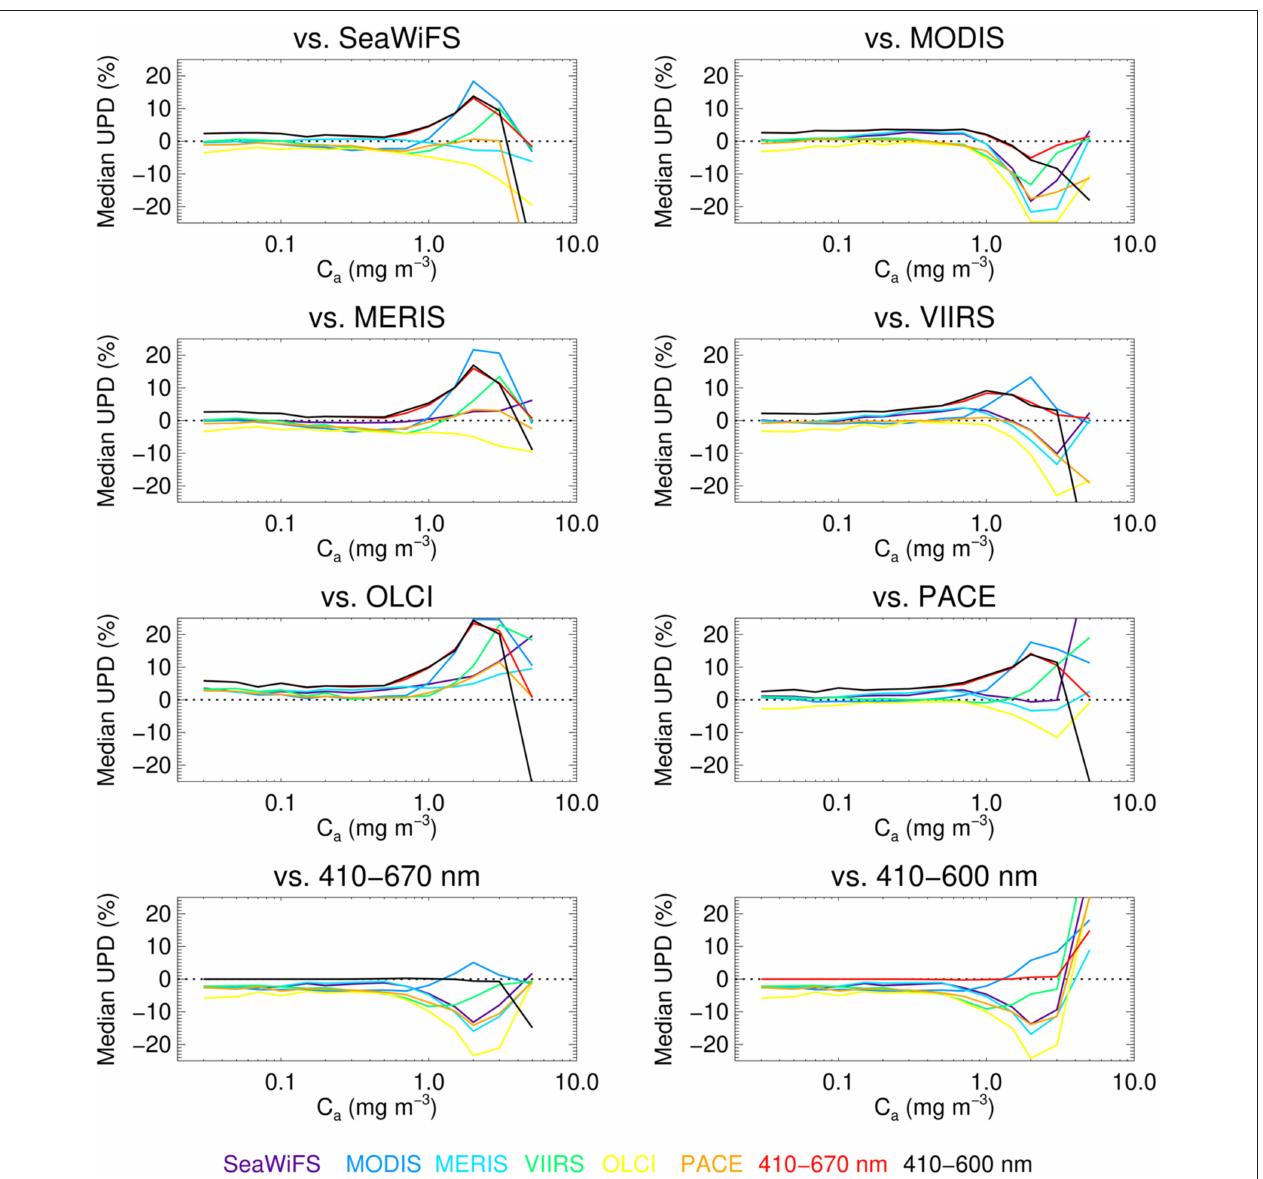
FIGURE 4 | As for Figure 3 , but for a dg